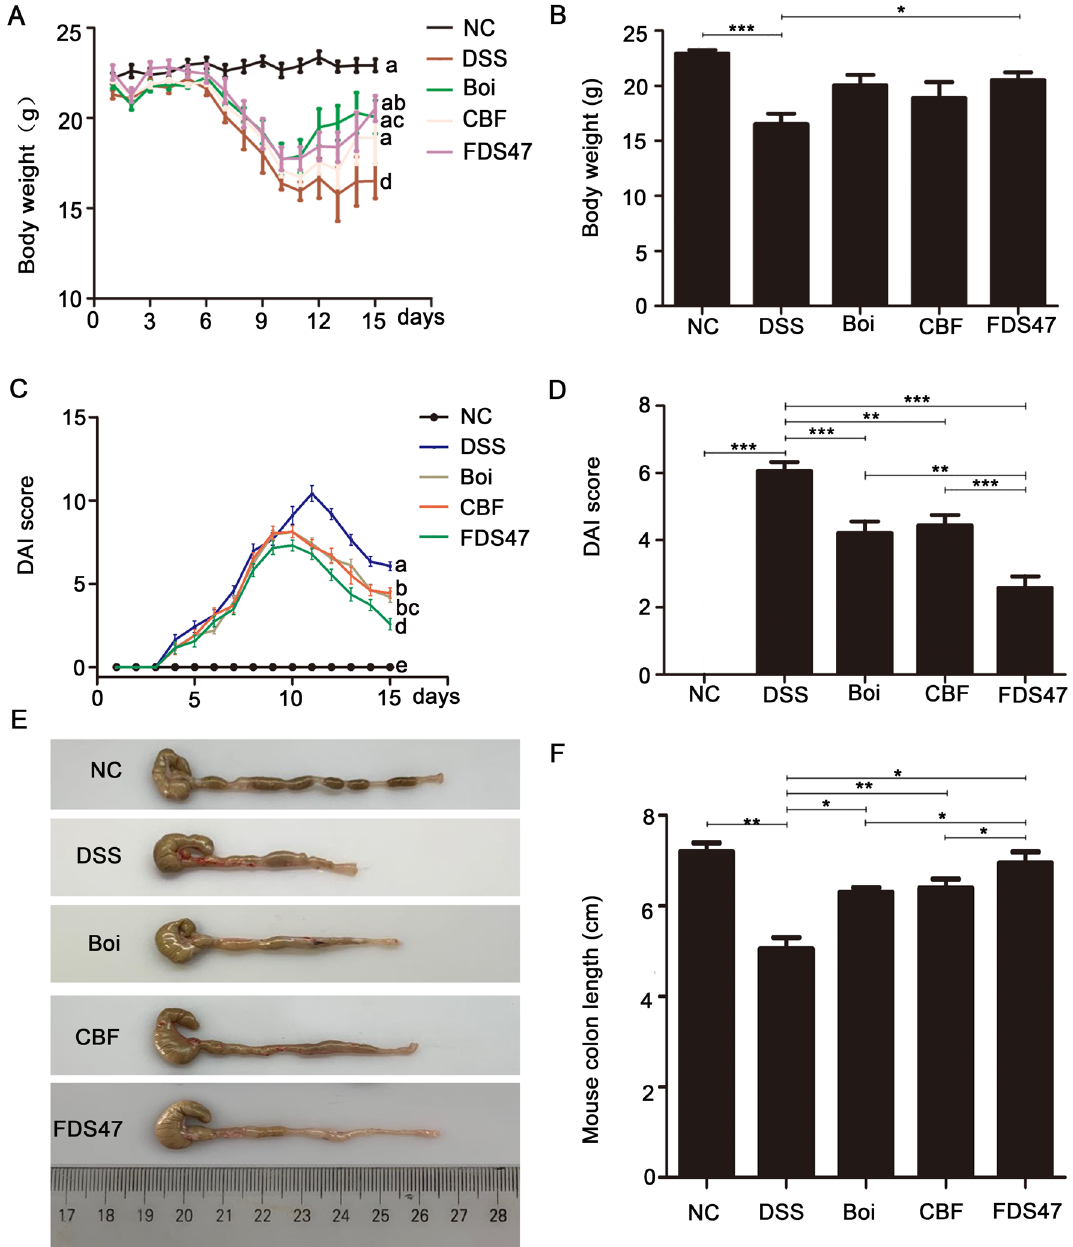
Figure 4. The effects of FDS47 on relieving DSS-induced UC mice was better than boiled Danshen itself or bacteria solution itself. NC (Negative control), FDS47 (fermented danshen sequence 47), Boi. (boiled), CBF (compound bacterium fluid). ( A ) The body weights of mice were detected every day. a-d represented significant differences among different groups by one-way ANOVA procedure followed ( p < 0.05). ( B ) The statistical analysis of the body weights at the 15th day. ( C ) DAI (disease activity index) score of mice was examined every day. a-e represented significant differences among different groups by one-way ANOVA procedure followed ( p < 0.05). ( D ) The statistical analysis of the DAI score at the 15th day. ( E ) The photos of colon length (one representative colon from each group). Images were processed by use of Adobe Photoshop SC6 (6.1, https:// www. adobe. com/ cn/ produ cts/ photo shop. html) ( F ) The colon lengths calculated from E. All groups (NC, Boi., CBF, FDS47) were statistically analyzed with the DSS group. The FDS47 group and other groups (Boi., CBF) were statistically analyzed from group to group. (Data are expressed as means ± S.E. # p > 0.05, * p < 0.05, ** p < 0.01 and *** p <